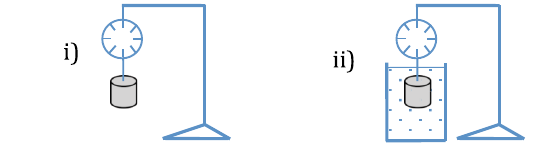
FIG. 4. An object suspended from a scale.